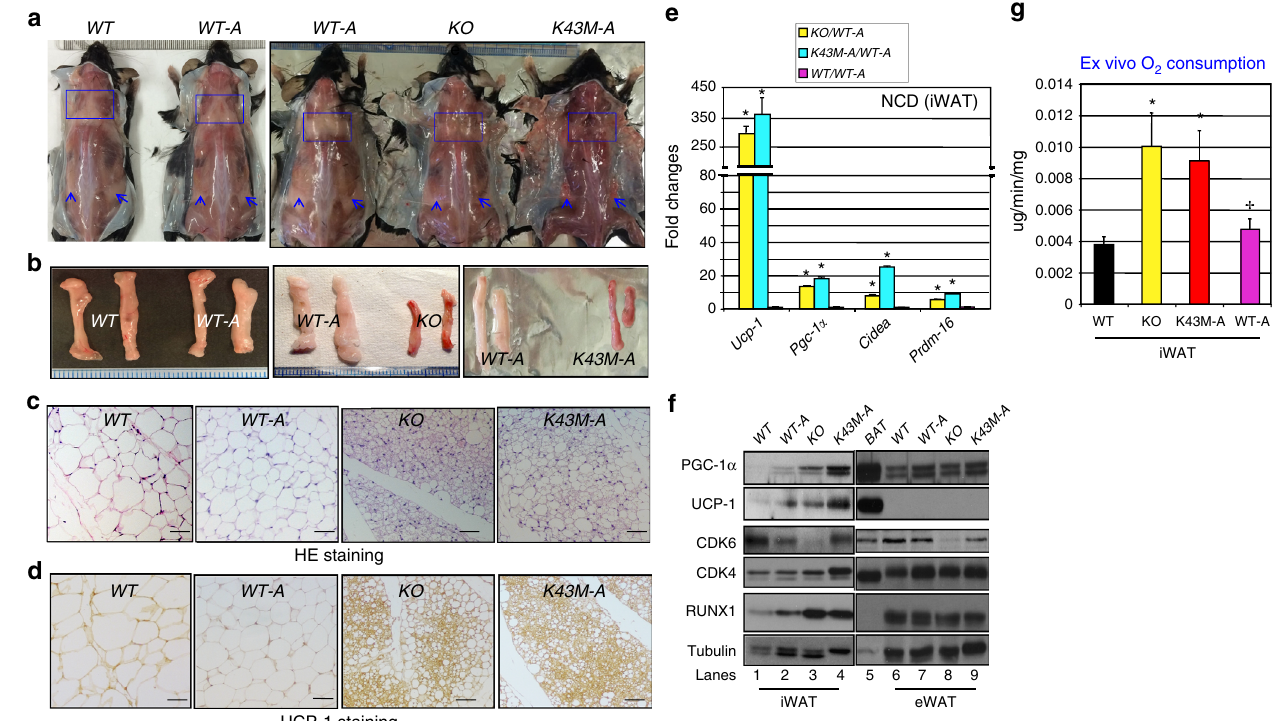
Fig. 4 Re-expression of CDK6 in mature adipocytes of KO mice reverses white fat browning. Loss of kinase activity in mature adipocytes preserves the effect of loss of kinase activity in germline on white fat browning. a Appearance of male (18 weeks of age) posterior-sWAT of NCD-fed WT , WT-A , KO , and K43M-A , emphasized with blue squares and arrows. b Appearance of isolated iWAT from the mice indicated in a . c Representative light microscopic images of H&E-stained sections of iWAT ( n = 6) from male (18 weeks of age) mice indicated in a (scale bars: 100 μ m). d Representative images of UCP-1 staining ( n = 6) of iWAT from mice indicated at 18 weeks of age (scale bars: 100 μ m). e Relative mRNA expression levels of BAT-speci fi c markers ( Ucp-1 , Pgc-1 α , Cidea , and Prdm16) of iWAT under NCD . Data shown are mRNA fold change normalized to their respective controls, WT or WT-A . * p < 0.05, n = 6, t -test, comparing experimental group vs its control. f Immunoblots of the indicated protein levels in iWAT and eWAT from 50 μ g of cell lysates. Twenty micrograms of cell lysates of BAT was used as a positive control for UCP-1 and PGC-1 α , and α -tubulin was utilized as an internal loading control. g Ex vivo oxygen consumption of iWAT homogenates from mice. Data are expressed as mean ± S.E., * p < 0.05, n = 6, vs WT , t -test. ✢ p < 0.05, n = 6 vs KO , t -test. See also Supplementary Figs. 3 and